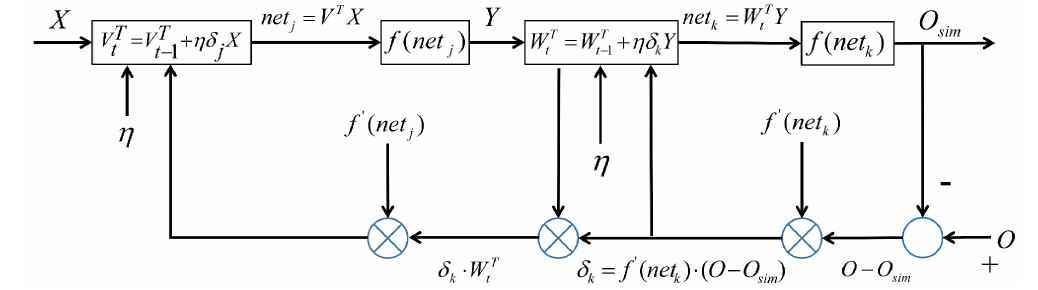
Figure 2. Algorithm of the proposed neural network.